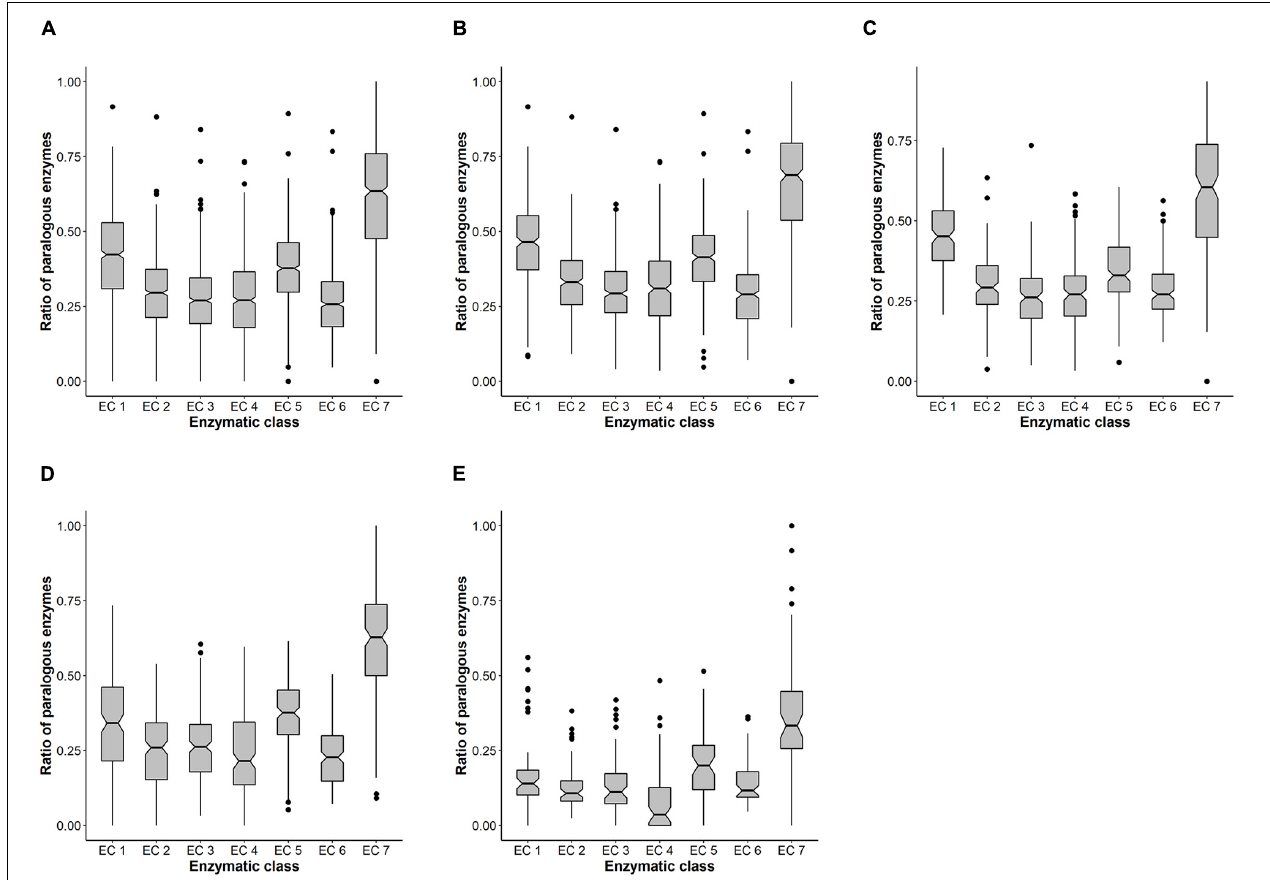
FIGURE 3 | Ratio of paralogous enzymes in prokaryotic organisms. In panel (A) , the ratio of paralogous enzymes is plotted for the whole sample and is separated by enzymatic class. For panels (B–E) , we also plot the ratio of paralogous enzymes for each enzymatic class but separated by the four different lifestyles in which we sorted our initial sample: (B) free-living organisms; (C) extremophiles; (D) pathogenic (non-intracellular) organisms; (E) intracellular organisms (both endosymbiont and intracellular